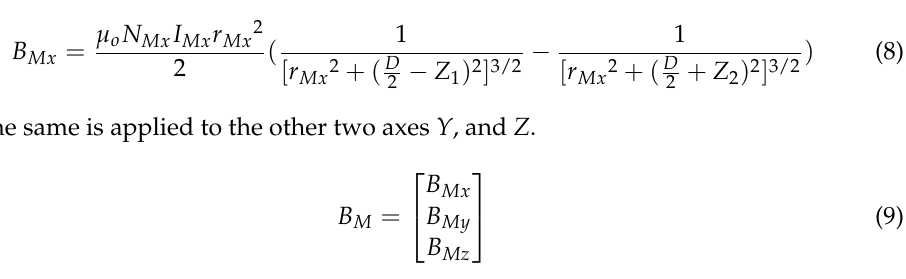
Figure 3. Pair of Maxwell coils with the same radius and opposite applied current